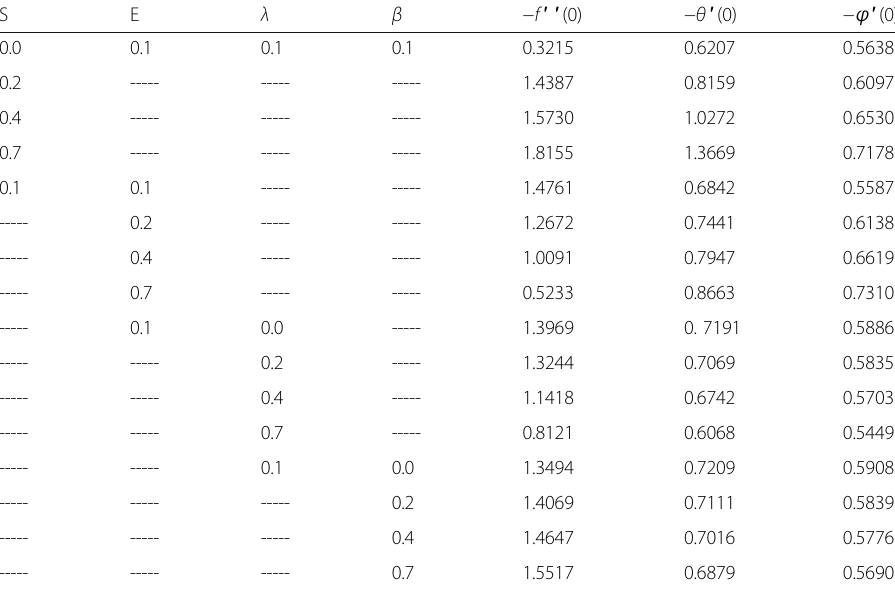
Table 3 Calculation of skin friction coefficient − f ′ ′ (0), local Nusselt number − θ ′ (0), and local Sherwood number − ϕ ′ (0) for different values of S , E , λ , and β when Nb = 0.1, Nt = 0.1, Pr = 2, Le = 2, R = 0.1, δ = 0.1, γ = 0.1, h = 0.1, and Q =